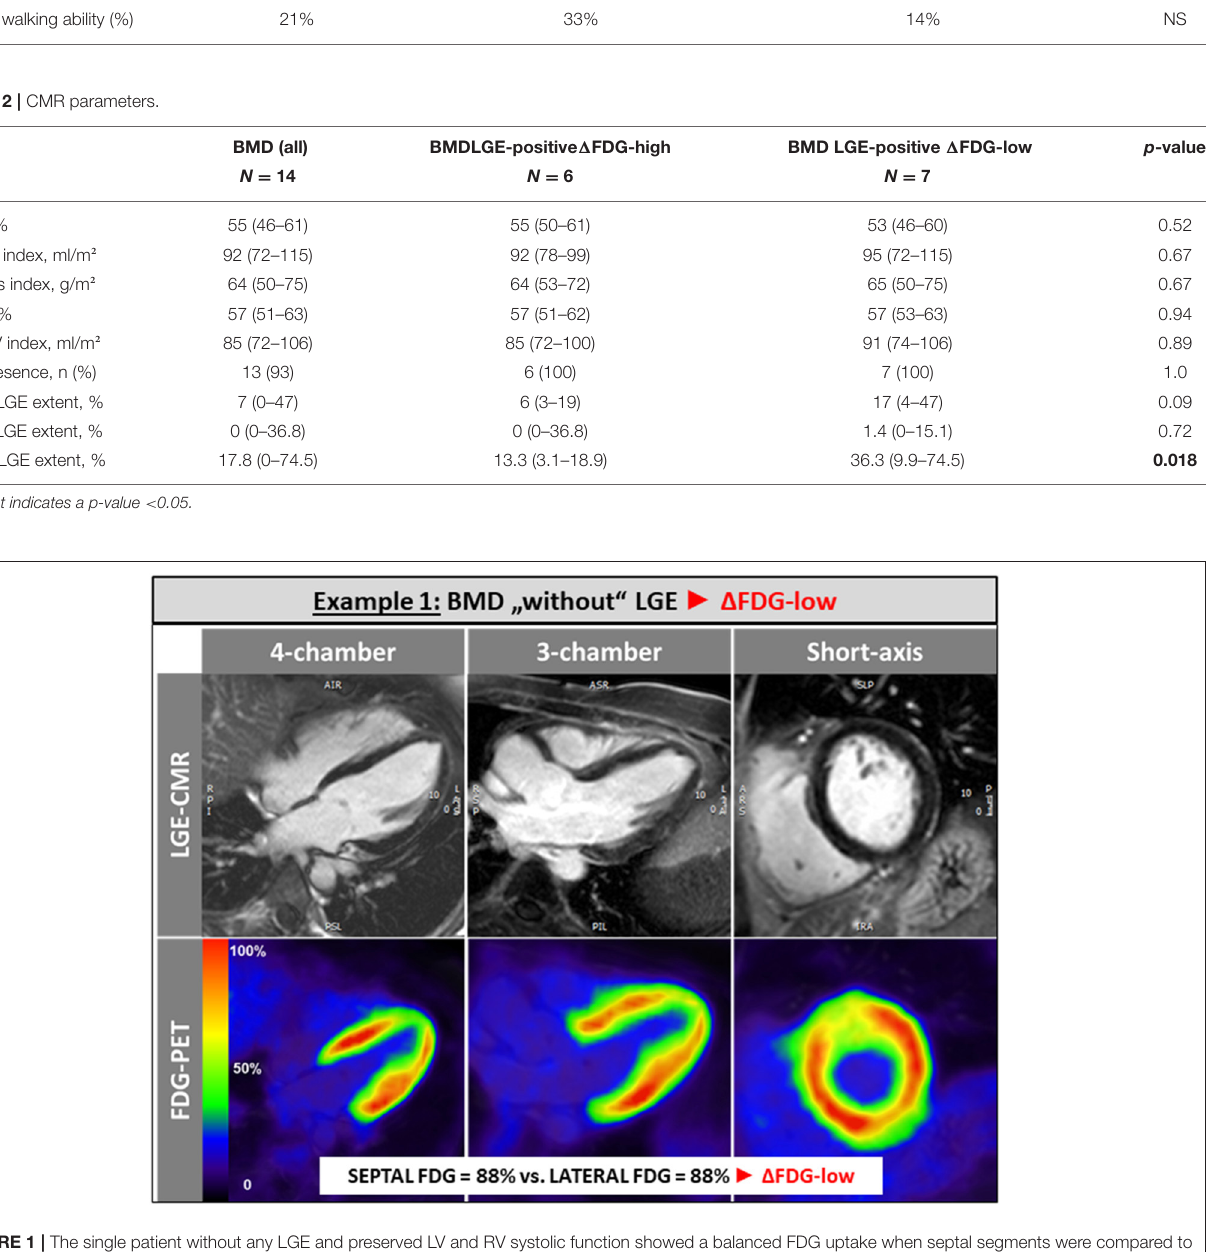
FIGURE 1 | The single patient without any LGE and preserved LV and RV systolic function showed a balanced FDG uptake when septal segments were compared to lateral ones.